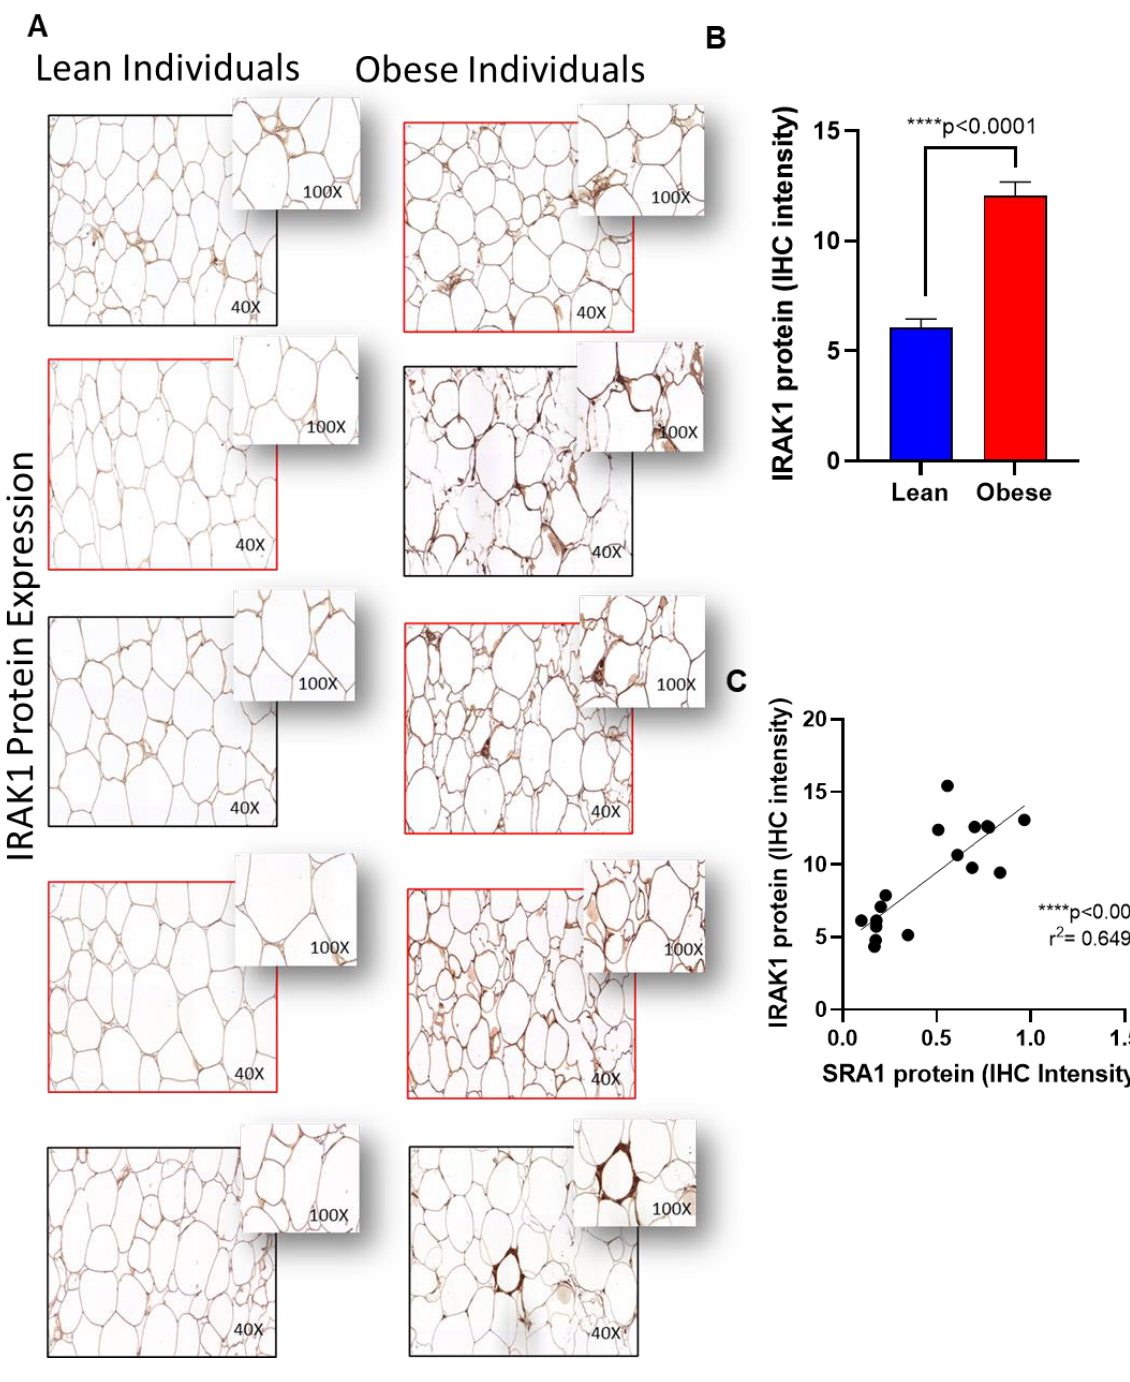
Figure 4. Adipose IRAK1 protein expression in adipose tissue and its correlation with SRA1 protein expression. IRAK1 protein expression was determined in adipose tissue samples from lean (normal weight; NW) and obese individuals (n = 8 for each group) using by immunohistochemistry (IHC) as described in Materials and Methods. IHC staining intensity was expressed as arbitrary units (AU) and the data (mean ± SEM) were compared between NW and obese populations using unpaired t -test and p < 0.05 was considered significant. ( A ) The representative IHC images are shown for NW and obese individuals. ( B ) IHC staining intensity data (AU). ( C ) Correlation between IRAK1 protein expression with SRA1.